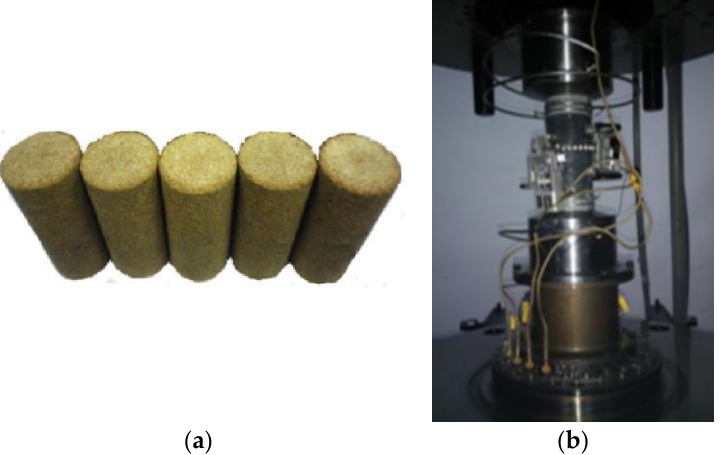
Figure 1. Photo of sandstone samples stress–strain curves of sandstone during failure under hydro-mechanical coupling. ( a ) Sandstone samples; ( b ) the mounted sample.